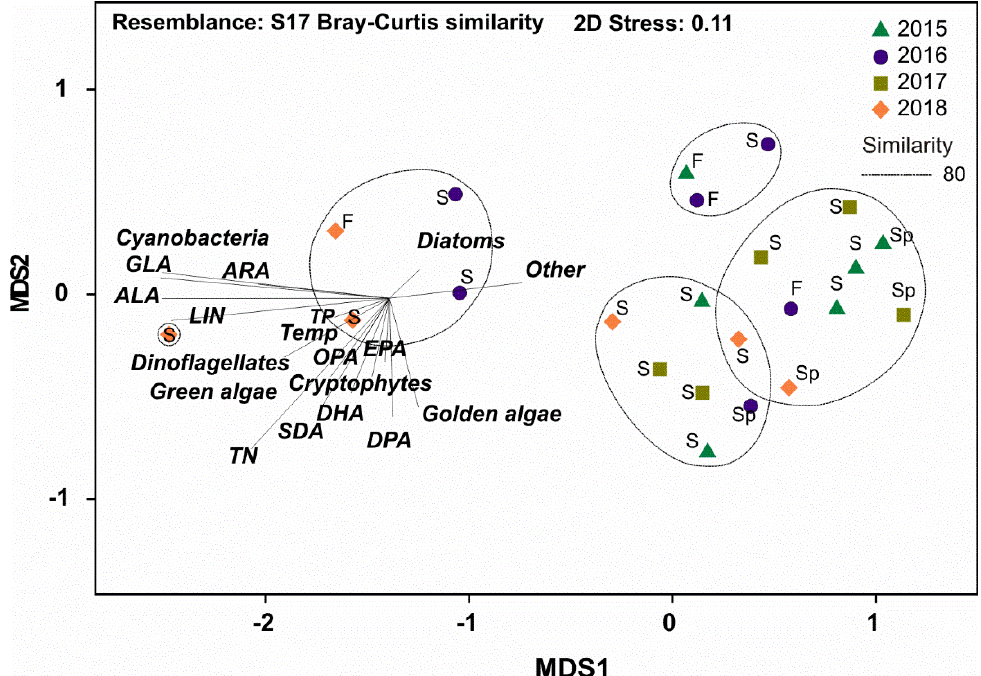
Figure 6. Non-metric multidimensional scaling plots of Bray Curtis similarity of ω -3 (ALA, SDA, EPA, DHA) and ω -6 (LIN, GLA, ARA, DPA) PUFA concentration of phytoplankton ( µ g PUFA L − 1 ), main phytoplankton groups and physico-chemical parameters in Lake Vesijärvi in years 2015–2018. TN—Total Nitrogen, TP—Total Phosphorus, Temp—temperature in the epilimnion. S = summer, F = fall, Sp =